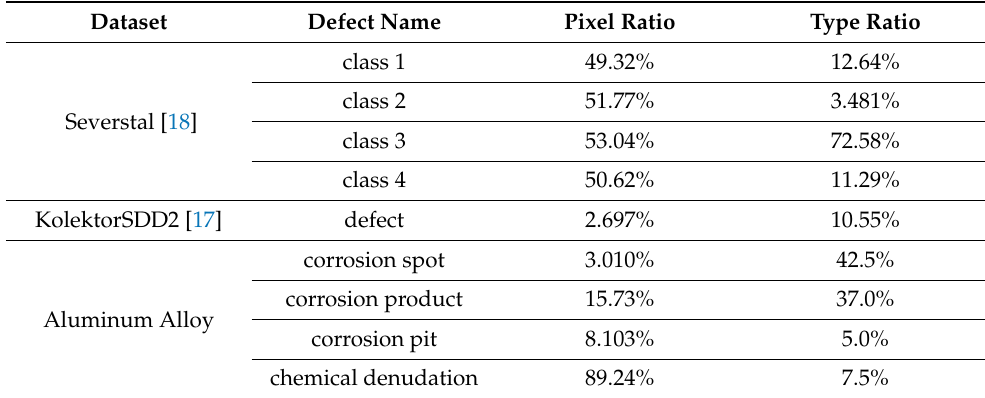
Table 2. Label imbalance in surface defect datasets. Pixel ratio is the mean ratio of defective pixels in the images. Type ratio is the ratio of the images in the dataset containing the